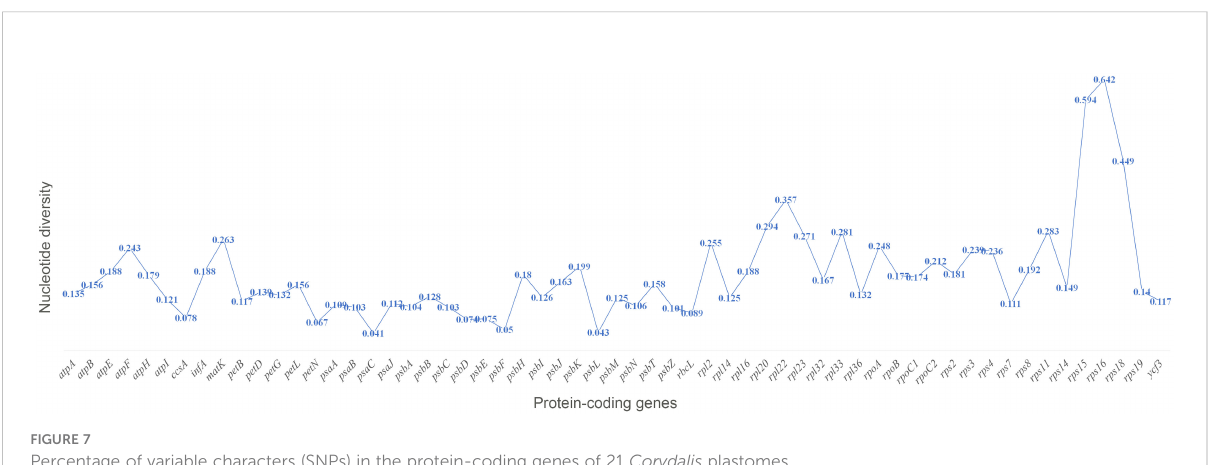
FIGURE 7 Percentage of variable characters (SNPs) in the protein-coding genes of 21 Corydalis